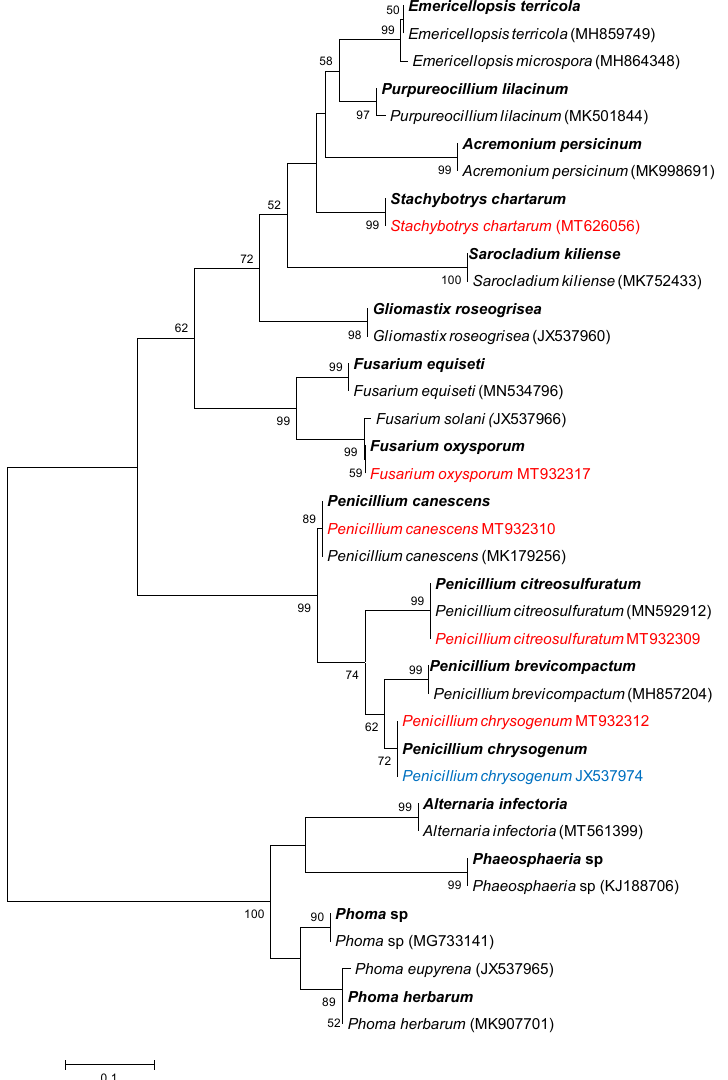
Figure 4. Phylogenetic analyses performed with the neighbor-joining method based on ITS1 sequences. The GenBank accession number of the sequences of fungal species used as reference species are indicated in brackets. The species represented in red and blue are those previously isolated from soil D [22] and from another PCB-polluted soil [20], respectively. The 16 species present in the 3 studied soils are in bold. Bootstrap values exceeding 50% are shown on the branches.